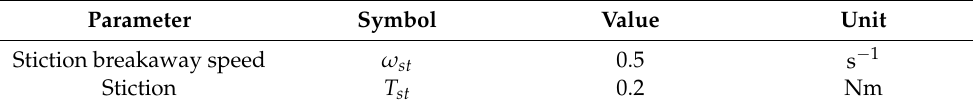
Table A4. Stiction model